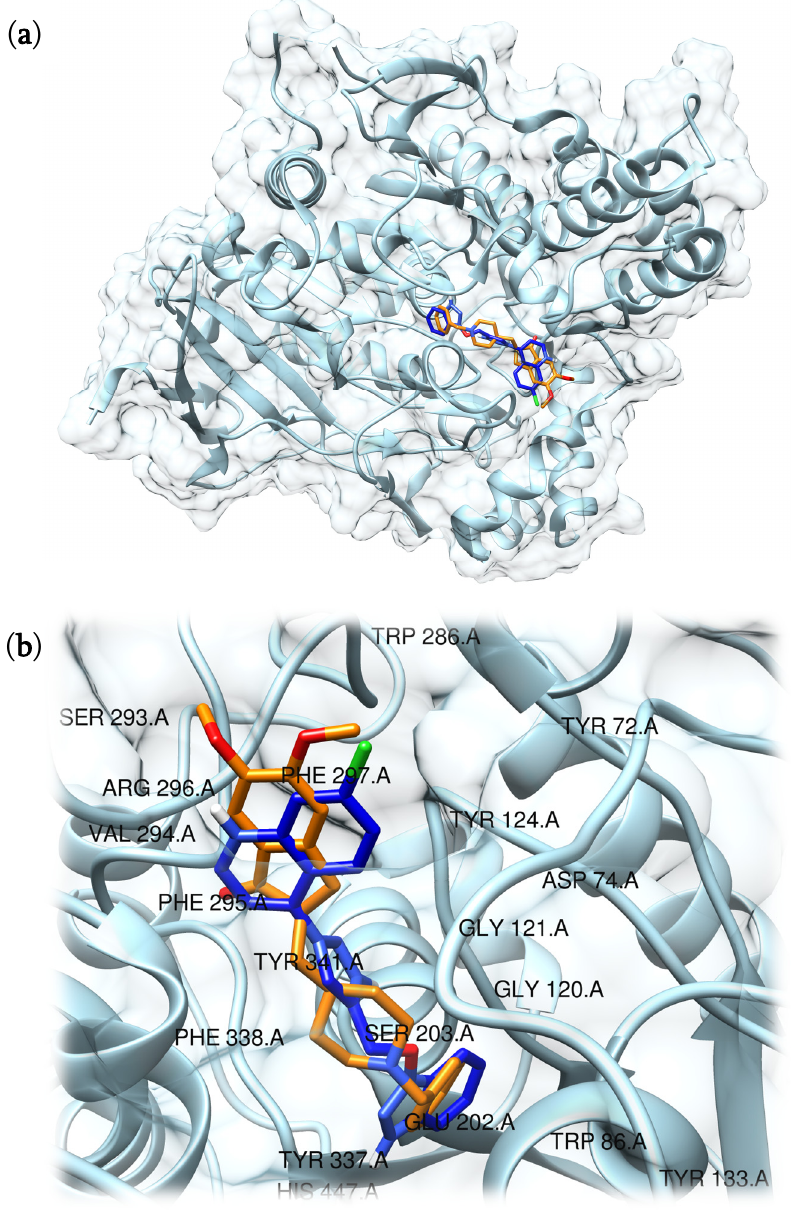
Figure 2. Predicted interaction motif for compound 5 (blue) with AChE and co-crystallized pose of donepezil within AChE (orange, PDB ID: 4EY7) ( a ); magnification of compound 5 (blue) in the binding site of AChE and comparison with donepezil (orange), the residues present in a zone of 5 Å radius from the center of the ligand have been labeled ( b ).